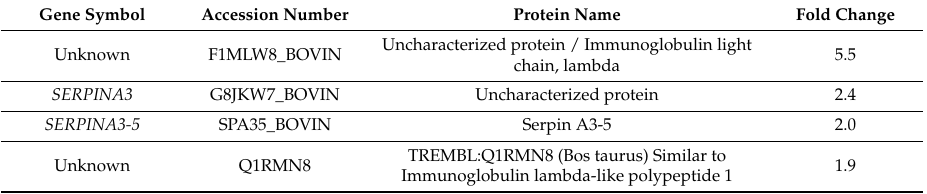
Table 2. The list of differentially expressed proteins (up- and down-regulated then alphabetic classification) 24 h after inflammation challenge by LPS in MG of underfed (REST; n = 6) compared with control (CONT; n = 6) cows. Proteins were analyzed with Progenesis LC-MS software v4.1 (Nonlinear Dynamics). The minimum mascot score validation for one peptide was 31 with a rate of false discovery